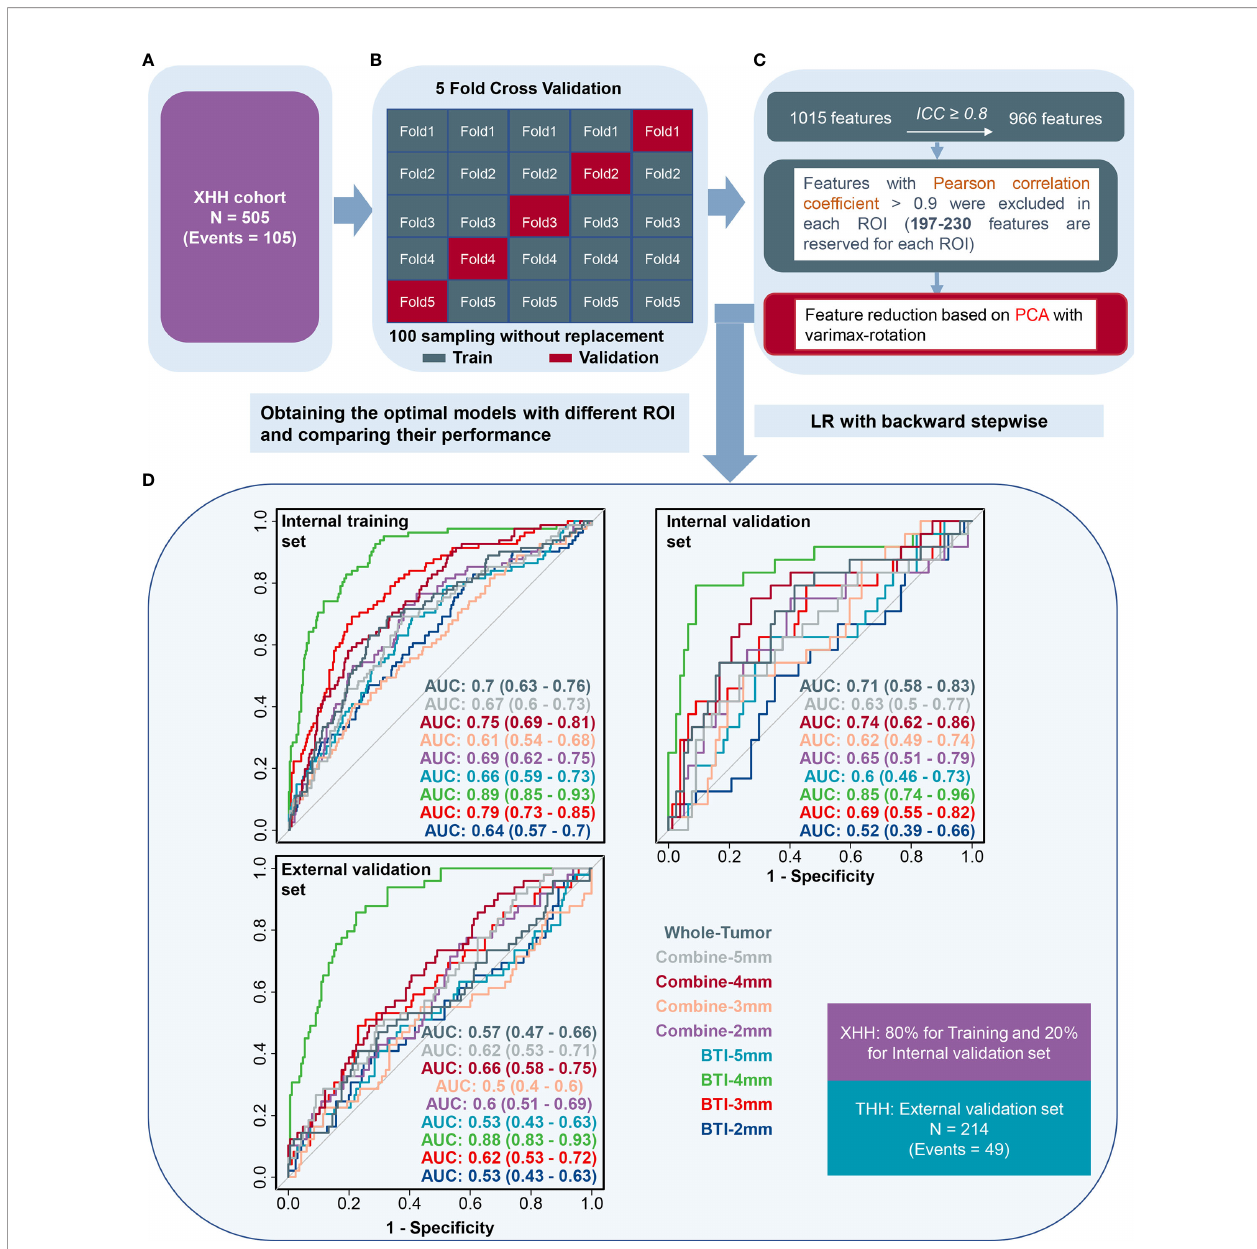
FIGURE 4 | The receiver operating characteristic curves when applying the backward stepwise LR algorithm. (A) Patients were split into the XHH cohort ( n = 505). (B , C) Feature selection, reduction and classi fi er establishment. (D) After feature reselection and PCA dimensional reduction, models were obtained based on principal